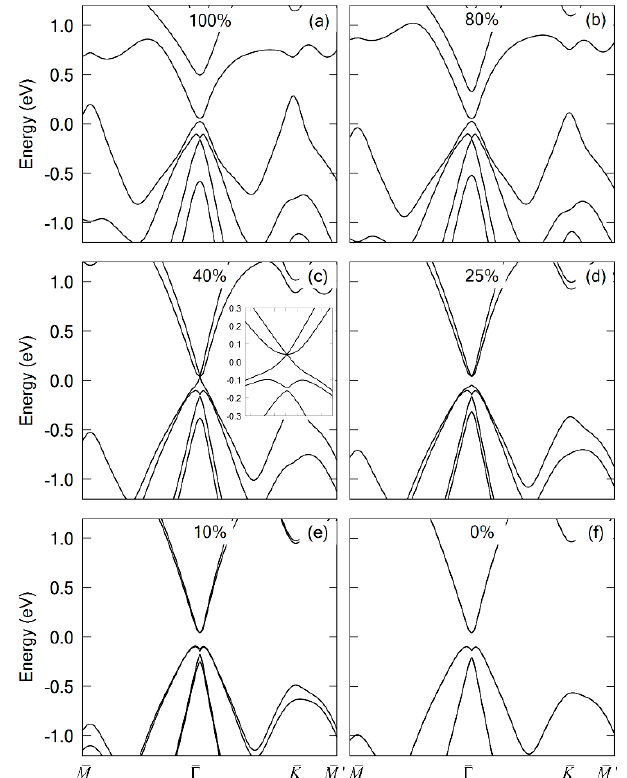
Figure 3. Band structure of double-bilayer bismuthene based on a tight binding model with the inter-bilayer hopping strength set at various levels as indicated. The inset in ( c ) is an enlargement of the band structure close to the Fermi level.